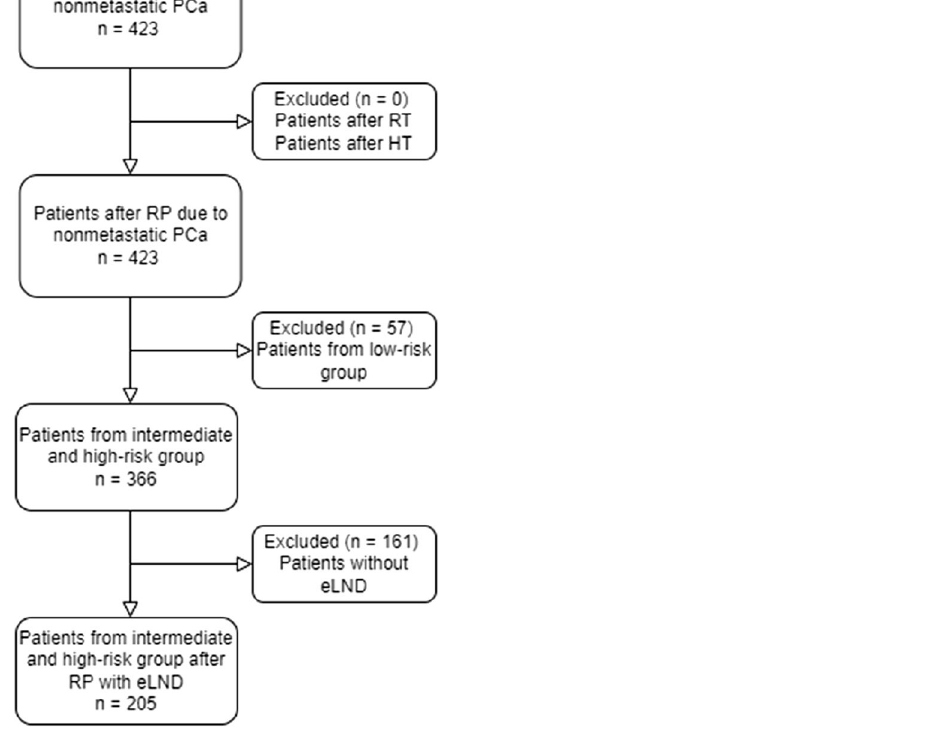
Figure 1. Inclusion and exclusion criteria—flow diagram. Graphics were printed using https:// app. diagr ams.